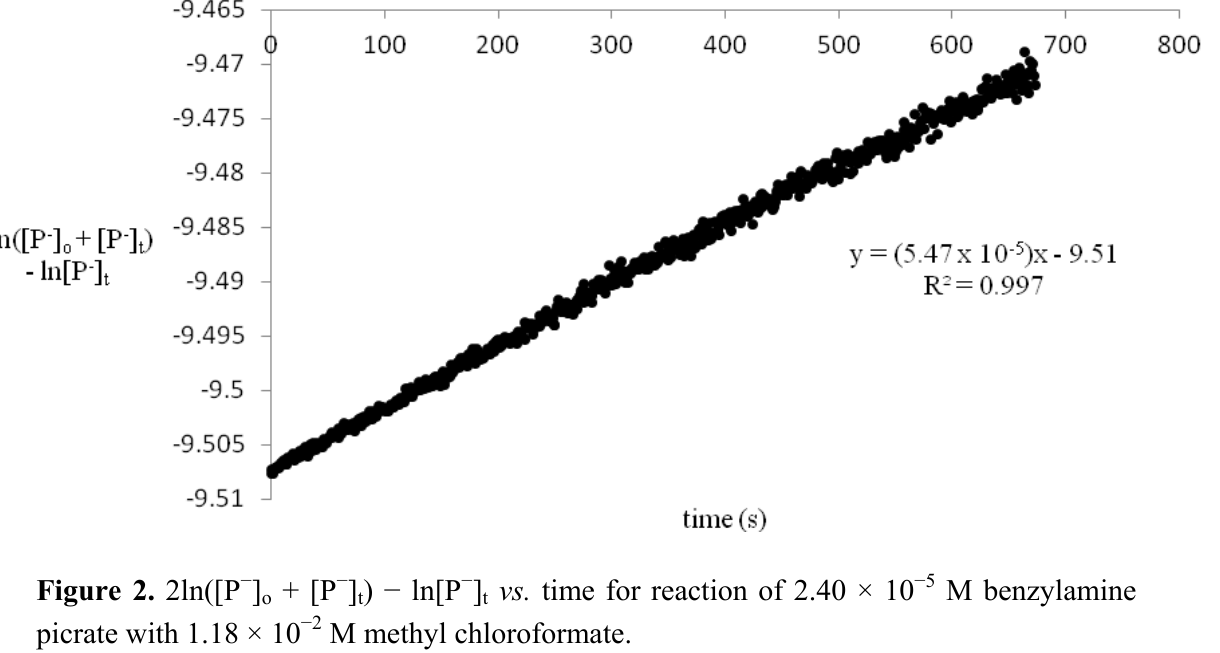
Figure 1. 2ln([P − ] picrate with 1.18 × 10 − 2 M benzoyl chloride.